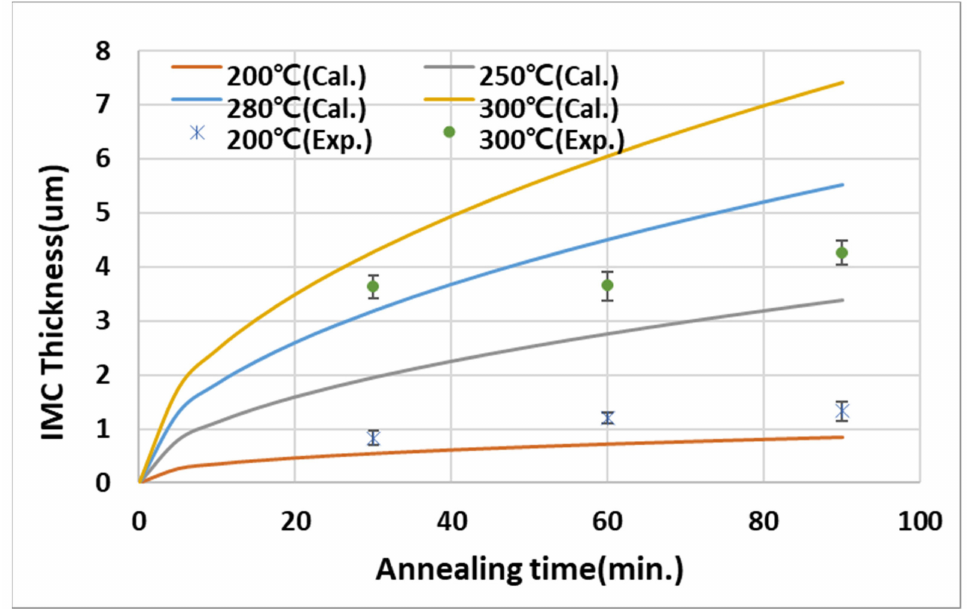
Figure 5. Cu 3 Sn growth behavior with annealing time. Solid lines were calculated using Equation (1); dots are experimental values.